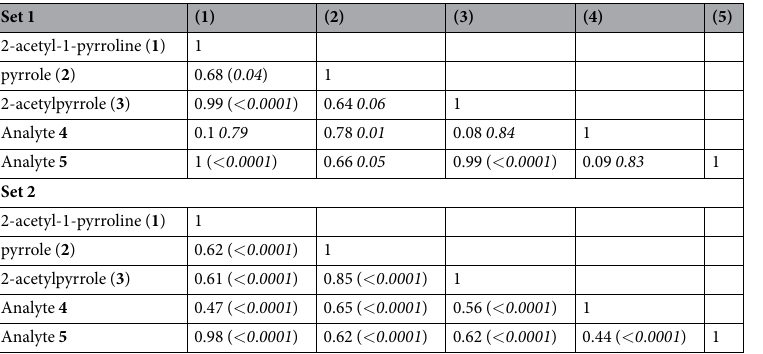
Table 1. Correlation coefficients of 2AP linked compounds in Set 1 (n = 11) and Set 2 (n = 341). P values are given in